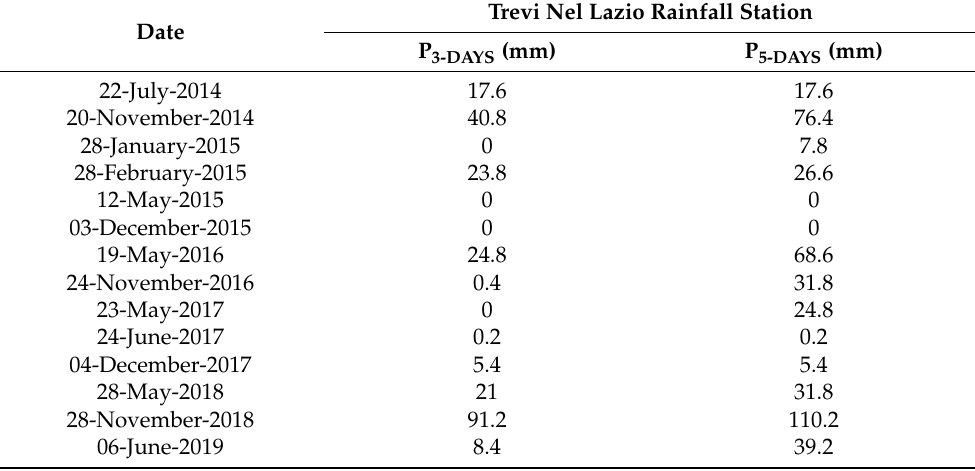
Table 4. 3-days and 5-days cumulative precipitation recorded at Trevi nel Lazio Rainfall Station before discharge measurements. The station is the nearest to the Pertuso Spring. Squared rows highlight intense rainfall